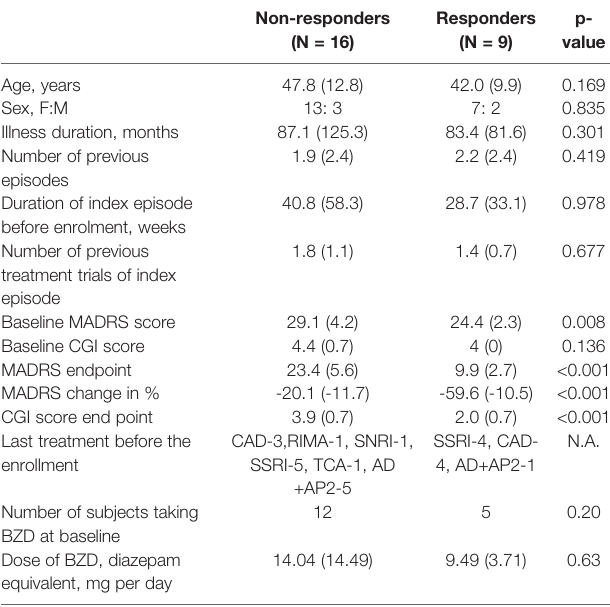
TABLE 1 | Demographic and clinical characteristics of non-responders and responders to LF rTMS